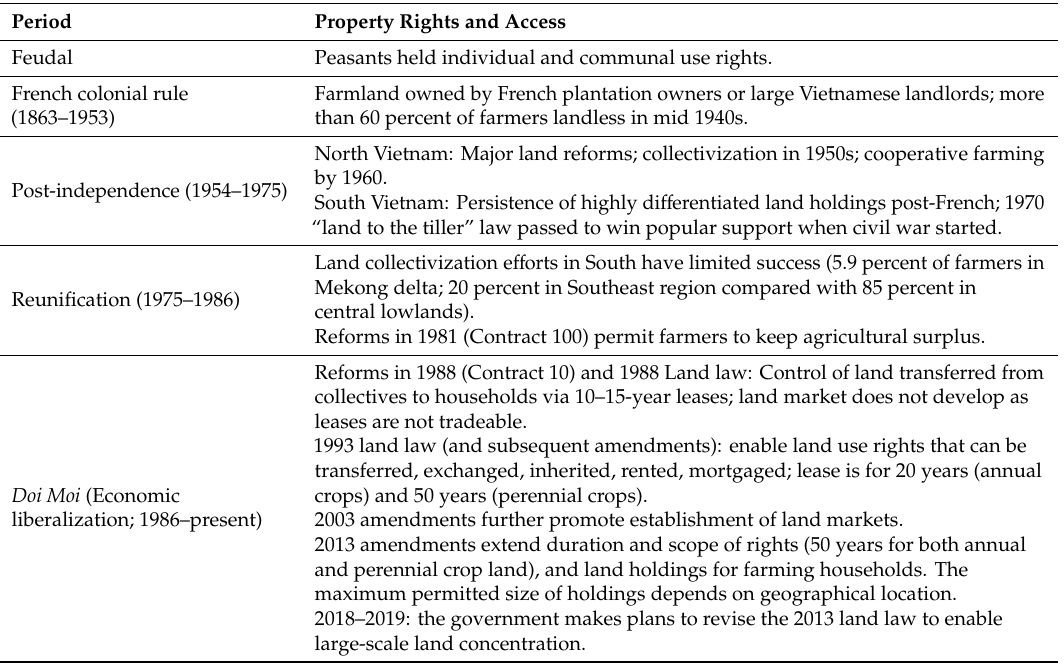
Table 1. Vietnam’s land governance over time. Sources: ([5,7,20,28–32] and